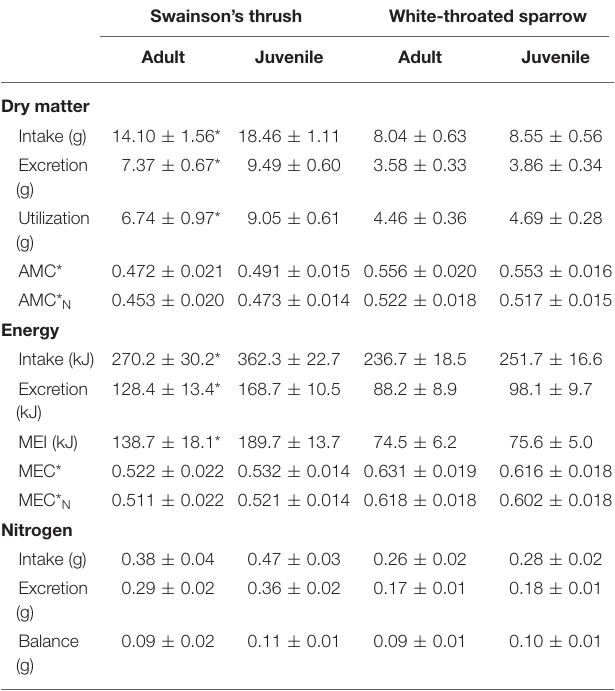
TABLE 4 | Measures of digestive efficiency and nitrogen balance from a 2-day total collection mass balance feeding trial for migrating adult and juvenile Swainson’s thrushes and white-throated sparrows captured on stopover at Long Point, Ontario, fall 2011.